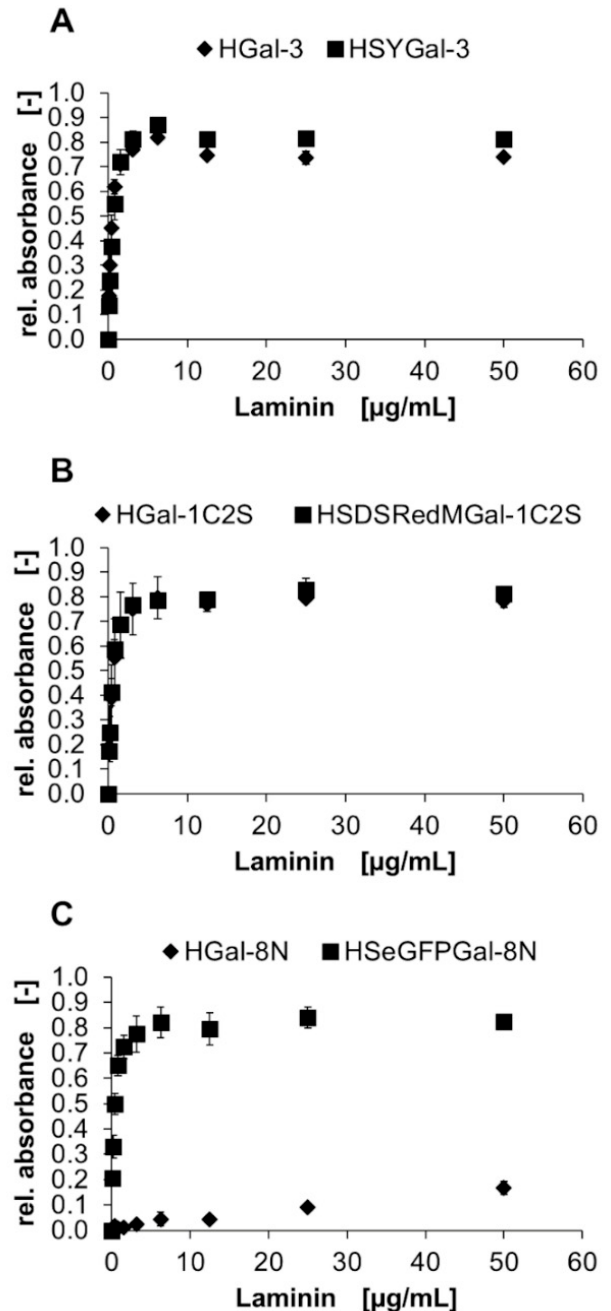
Figure 3. Comparison of Gal-3 binding on ASF depending on the purification mode. The binding of HGal-3 ( (cid:4496)(cid:4497) ) and HSYGal-3 ( ⬛ ) is shown for IMAC-purified ( A ) and IMAC/ASF-resin-purified ( B ) galectins. Galectin binding was detected with a peroxidase-conjugated anti-His 6 -antibody and conversion of TMB as the mean signal of three data points. Errors indicate standard deviations.